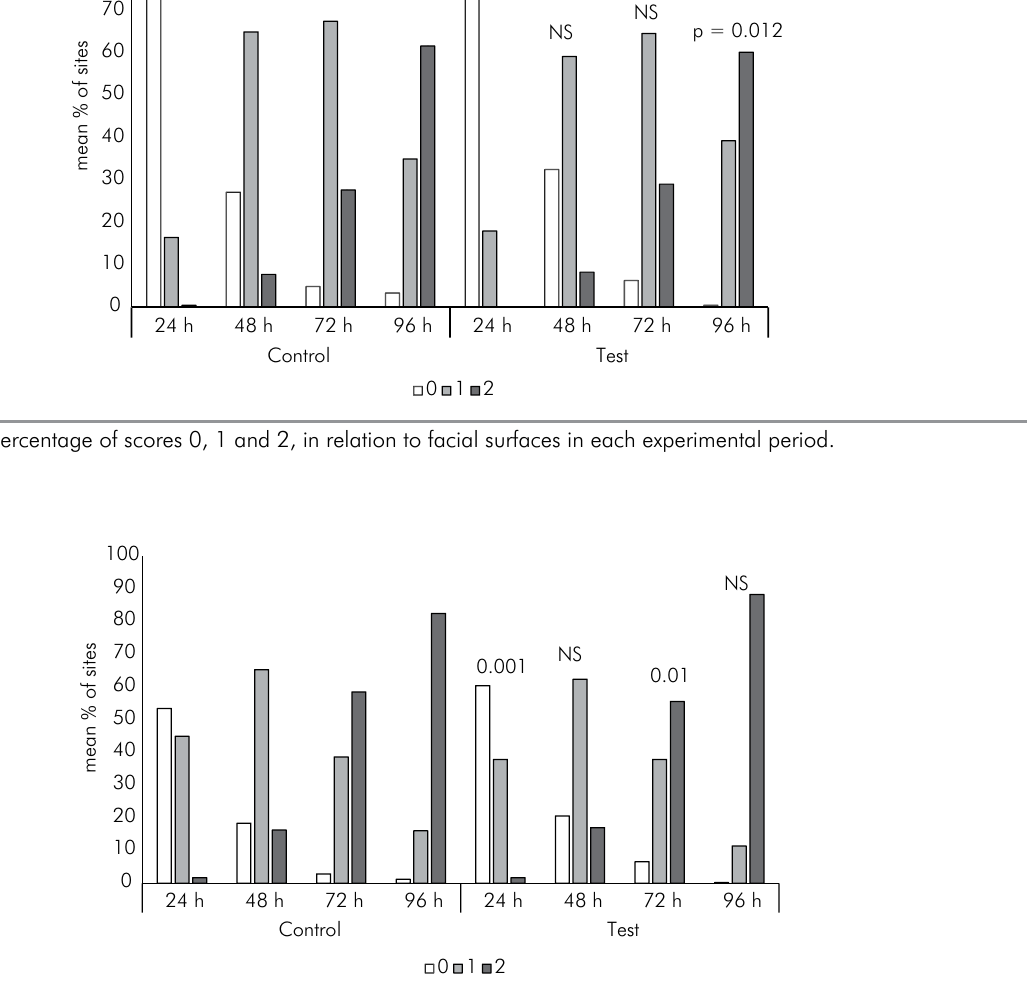
5 Braz Oral Res [online].